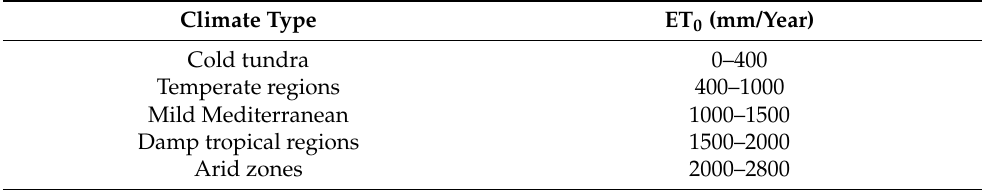
Table 5. General ET 0 ranges for different climate